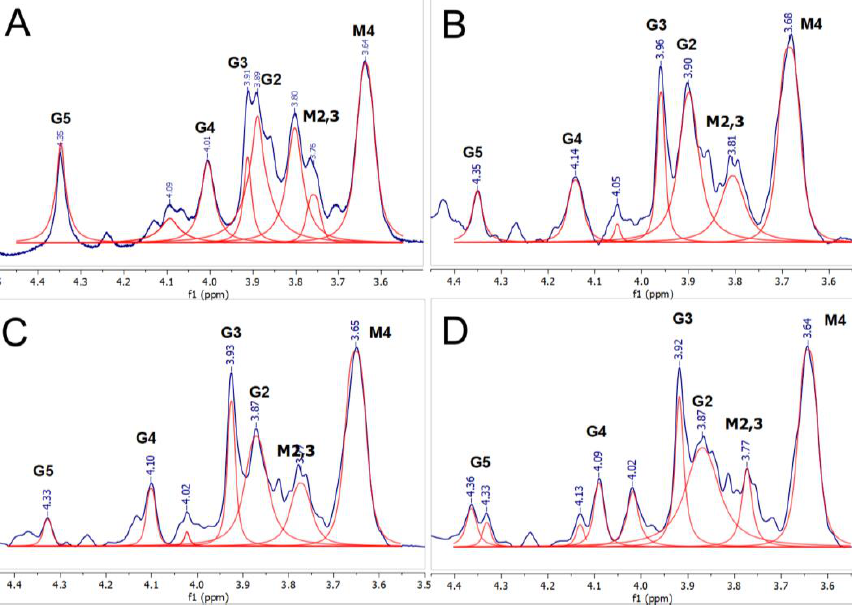
Figure 6. 1 H NMR spectra of ALG-Ca, cross-linked by different quantities (μmol) of Ca 2+ : ( A ) 0.3 μmol, ( B ) 2.5 μmol; ( C ) 5.5 μmol; ( D ) 25 μmol. Fitting is represented by red lines, fitting baseline is shown at the bottom.